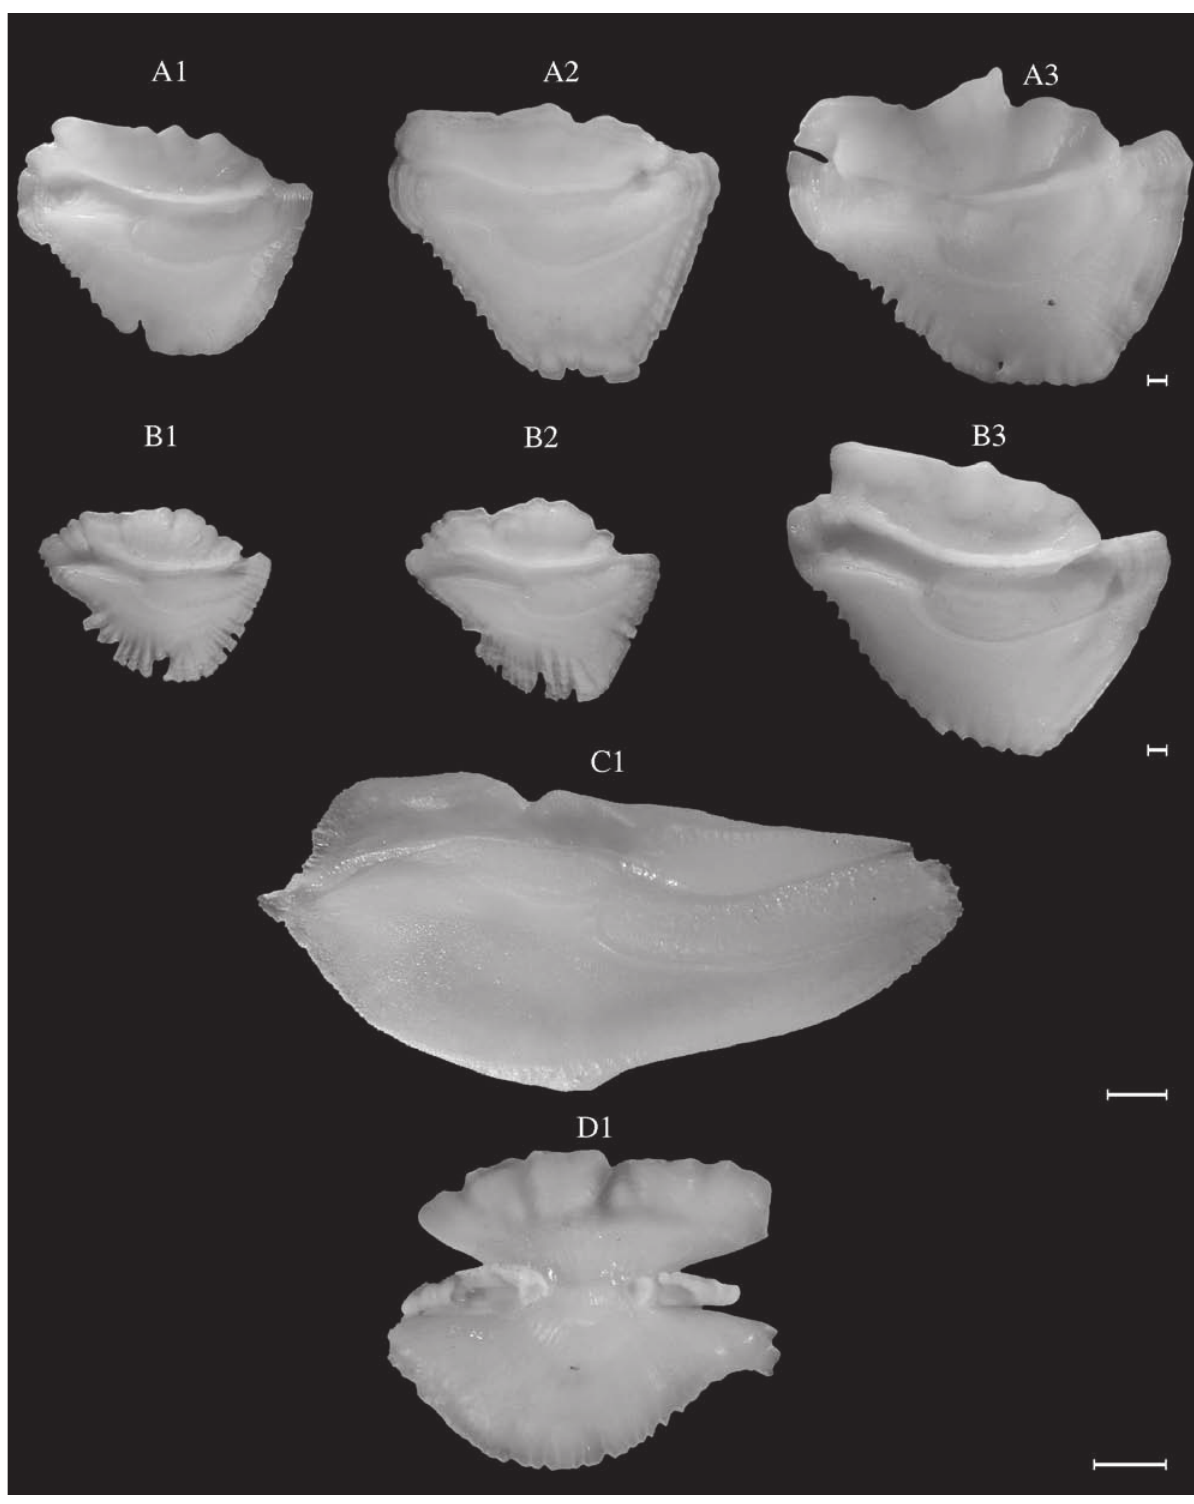
Fig. 38. – Beryx decadactylus . TL: A1, 31.5 cm (CEA); A2, 45.8 cm (NEA); A3, 54.2 cm (CEA). Beryx splendens . TL: B1, 28.3 cm (CEA); B2, 30.9 cm (NEA); B3, 48.9 cm (CEA). Holocentrus adscensionis (CEA). TL: C1, 30.3 cm. Grammicolepis brachiusculus (CEA). SL, D1, 42.4 cm. Scale bar = 1